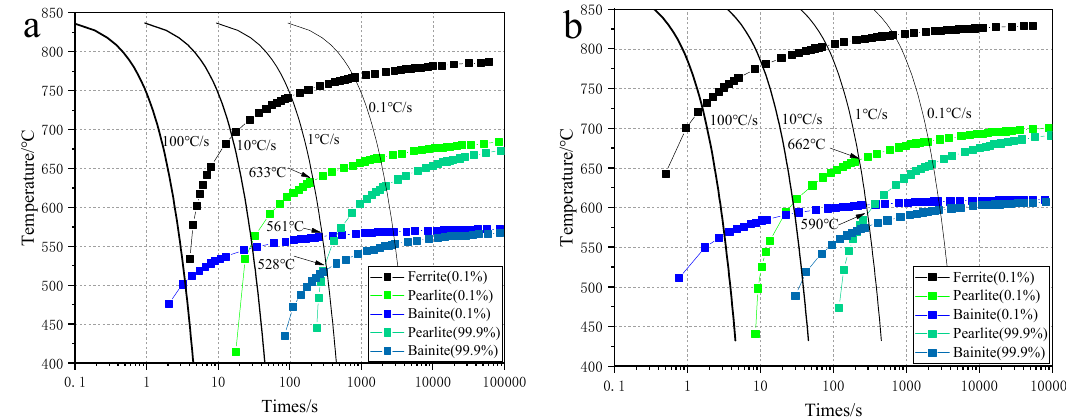
Figure 7. CCT diagram of the central segregation region of steel. ( a ) Steel 1; ( b ) Steel 2. Mechanical properties are caused by the microstructure of